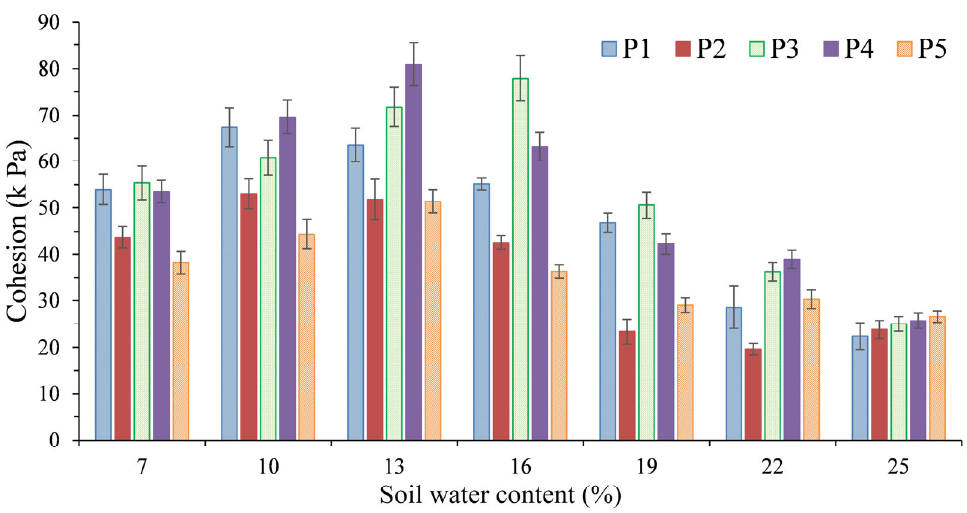
Figure 6. Cohesion with respect to the total stress for di ff erent sample points (P1, P2, P3, P4, and P5) at di ff erent water contents (7%, 10%, 13%, 16%, 19%, 22%, and